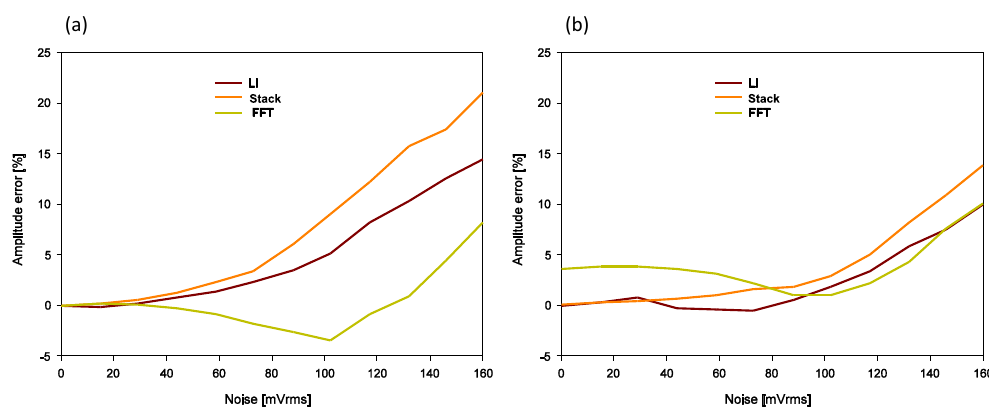
Figure 13. (a) Comparison of LI, stack and FFT over pink noise without overshoot. (b) Comparison of LI, stack and FFT over pink noise with